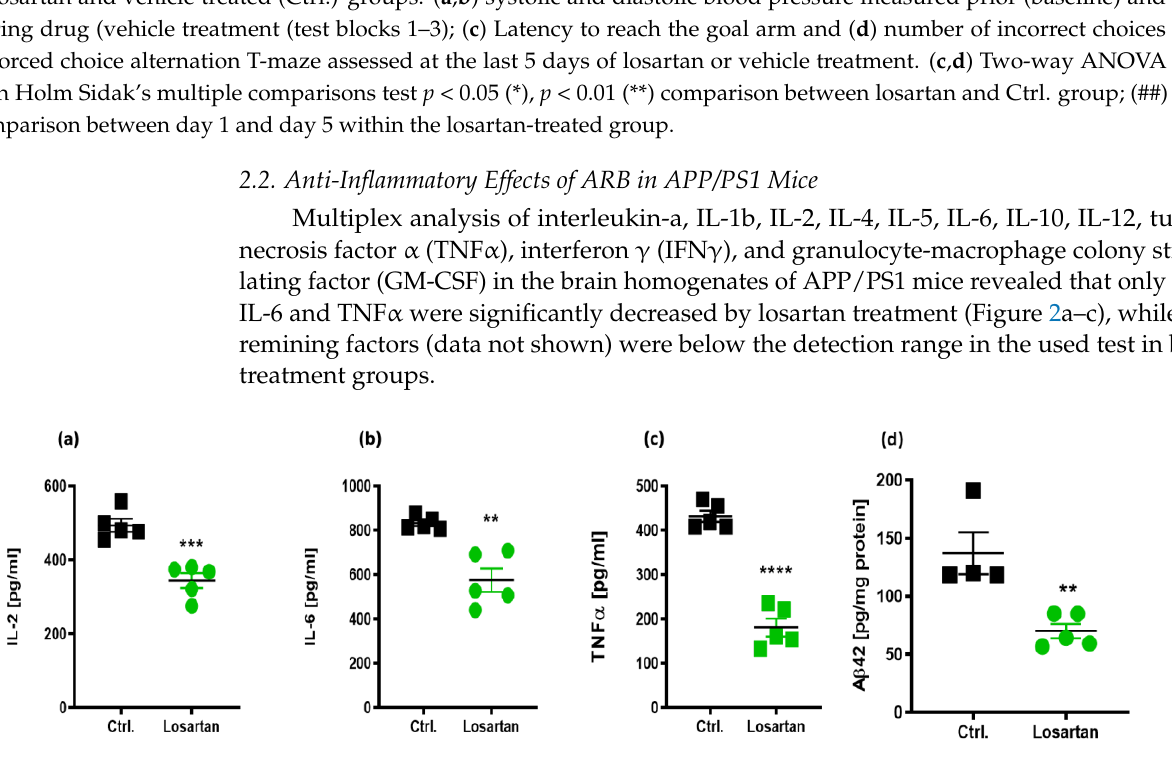
Figure 2. Cerebral content of inflammatory cytokines and soluble beta Amyloid peptide 42 (A β 42) in losartan and vehicle treated APP/PS1 mice. Brain homogenates of APP/PS1 mice ( n = 5) were assessed for the levels of inflammatory cytokines. IL-2 ( a ), IL-6 ( b ), and TNF α ( c ) in losartan and vehicle treated (Ctrl.) groups. ( d ) Brain content of soluble A β 42 in losartan and vehicle treated APP/PS1 mice. t -test, ** p < 0.01, *** p < 0.0005, **** p < 0.0001.